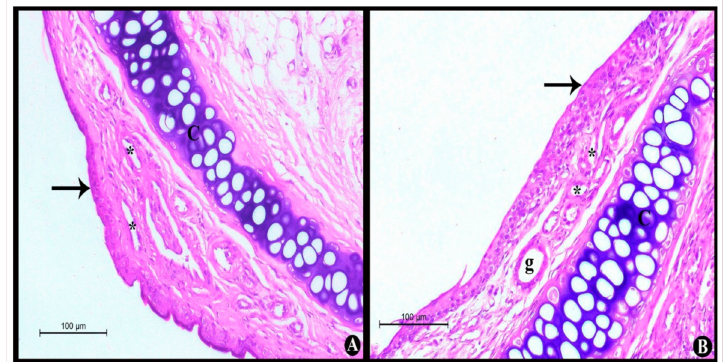
Figure 6. Light photomicrographs show ( A ) nasal epithelium without any administration (control); and ( B ) nasal epithelium after applying BER-CTS-NLCs. Notice normal nasal epithelium (arrows), normal lamina propria containing gland (g), capillaries (*), and normal nasal cartilage ( C ). H&E stain ×